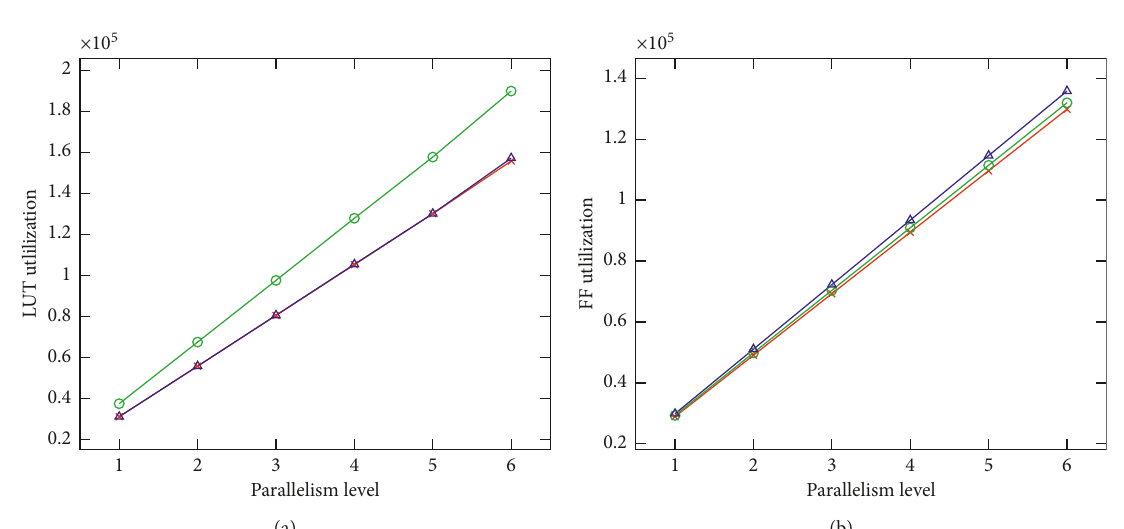
Figure 5: LUT/FF utilization at different parallelism levels for Default strategy at 100MHz, Default strategy at 200MHz, and Per- formance_Explore strategy at